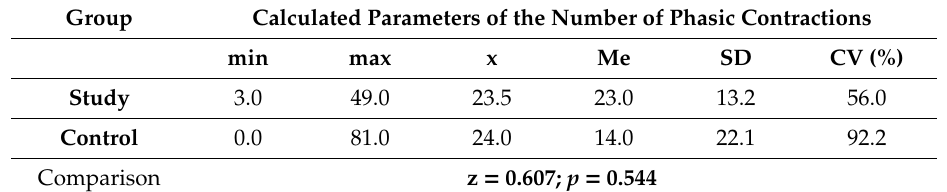
Table 7. Comparison of mean phasic contractions in patients in the study group and in the control group. Group Calculated Parameters of the Number of Phasic Contractions